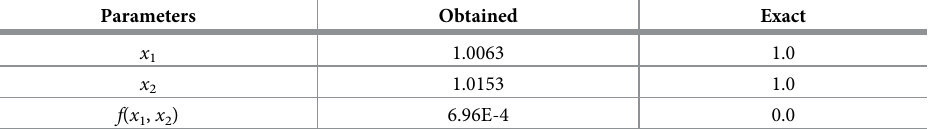
Table 2. Results of the PSO-Kmeans-ANMS algorithm for the Rosenbrock function. The number of objective func- tion evaluations in Phases 1 and 2 corresponds, respectively, to 1008 and